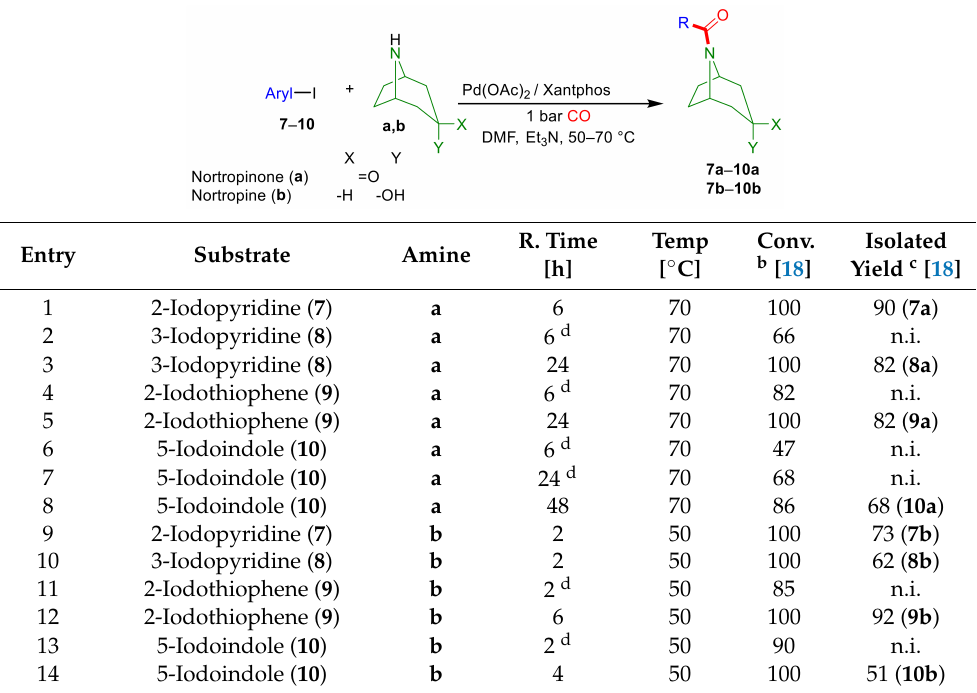
Table 2. Aminocarbonylation of nortropane-based nucleophiles ( a , b ) in the presence of